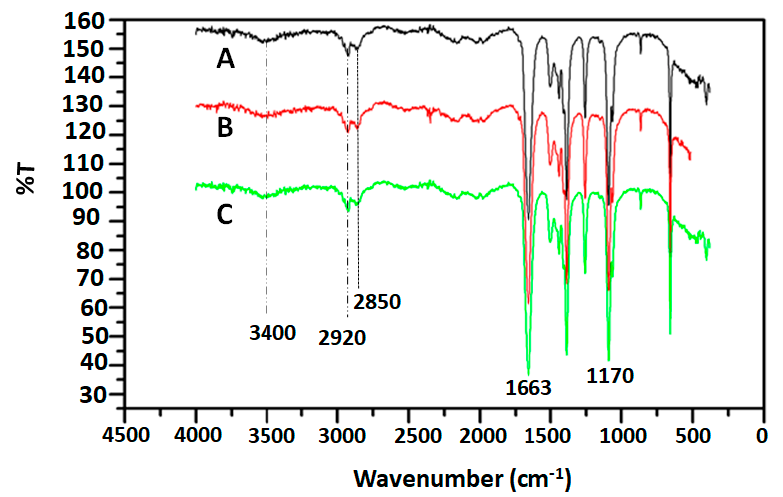
Figure 3. FT-IR spectra of ( A ) PDMA (black line), ( B ) PDMA–PVS (red line) and ( C ) PDMA–PVS–Ag 0 (green line) nanocomposites.